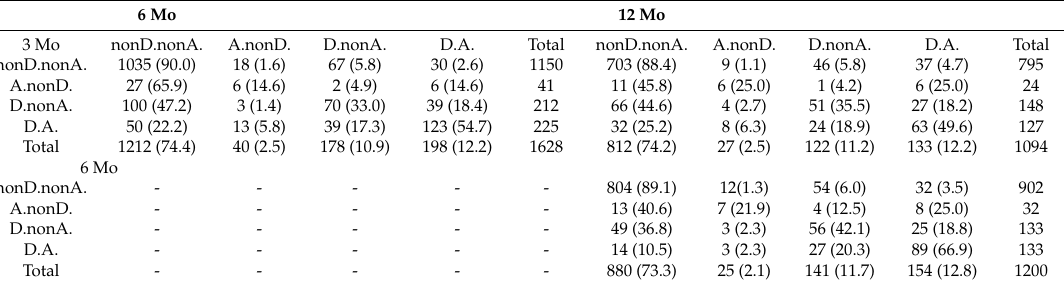
Table A4. The cross-table of depression and anxiety categories (cut-o ff point of 8). 6 Mo 12